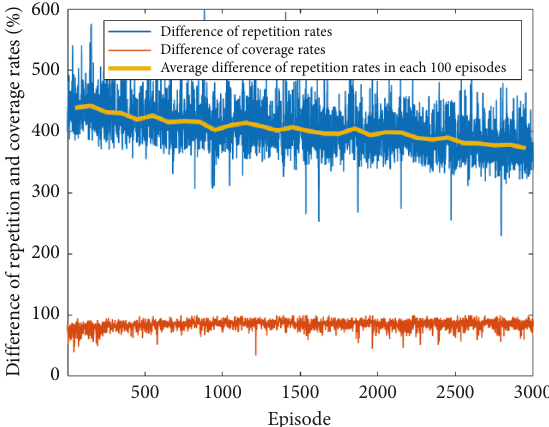
Figure 6: The training results when i � j �